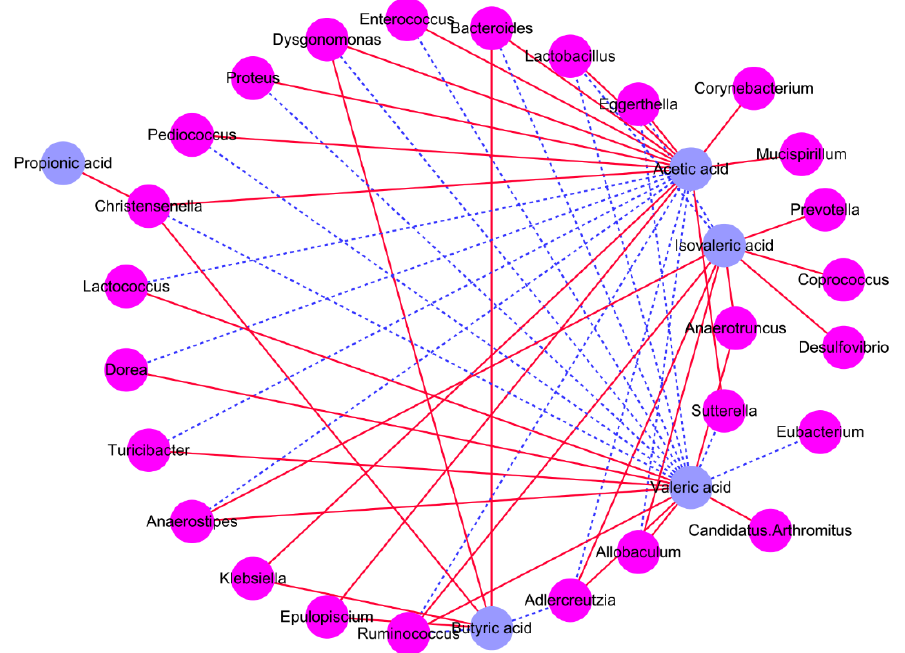
Figure 4. Correlation analysis between the specific compositional features of intestinal microbiota and the concentrations of cecal SCFAs.